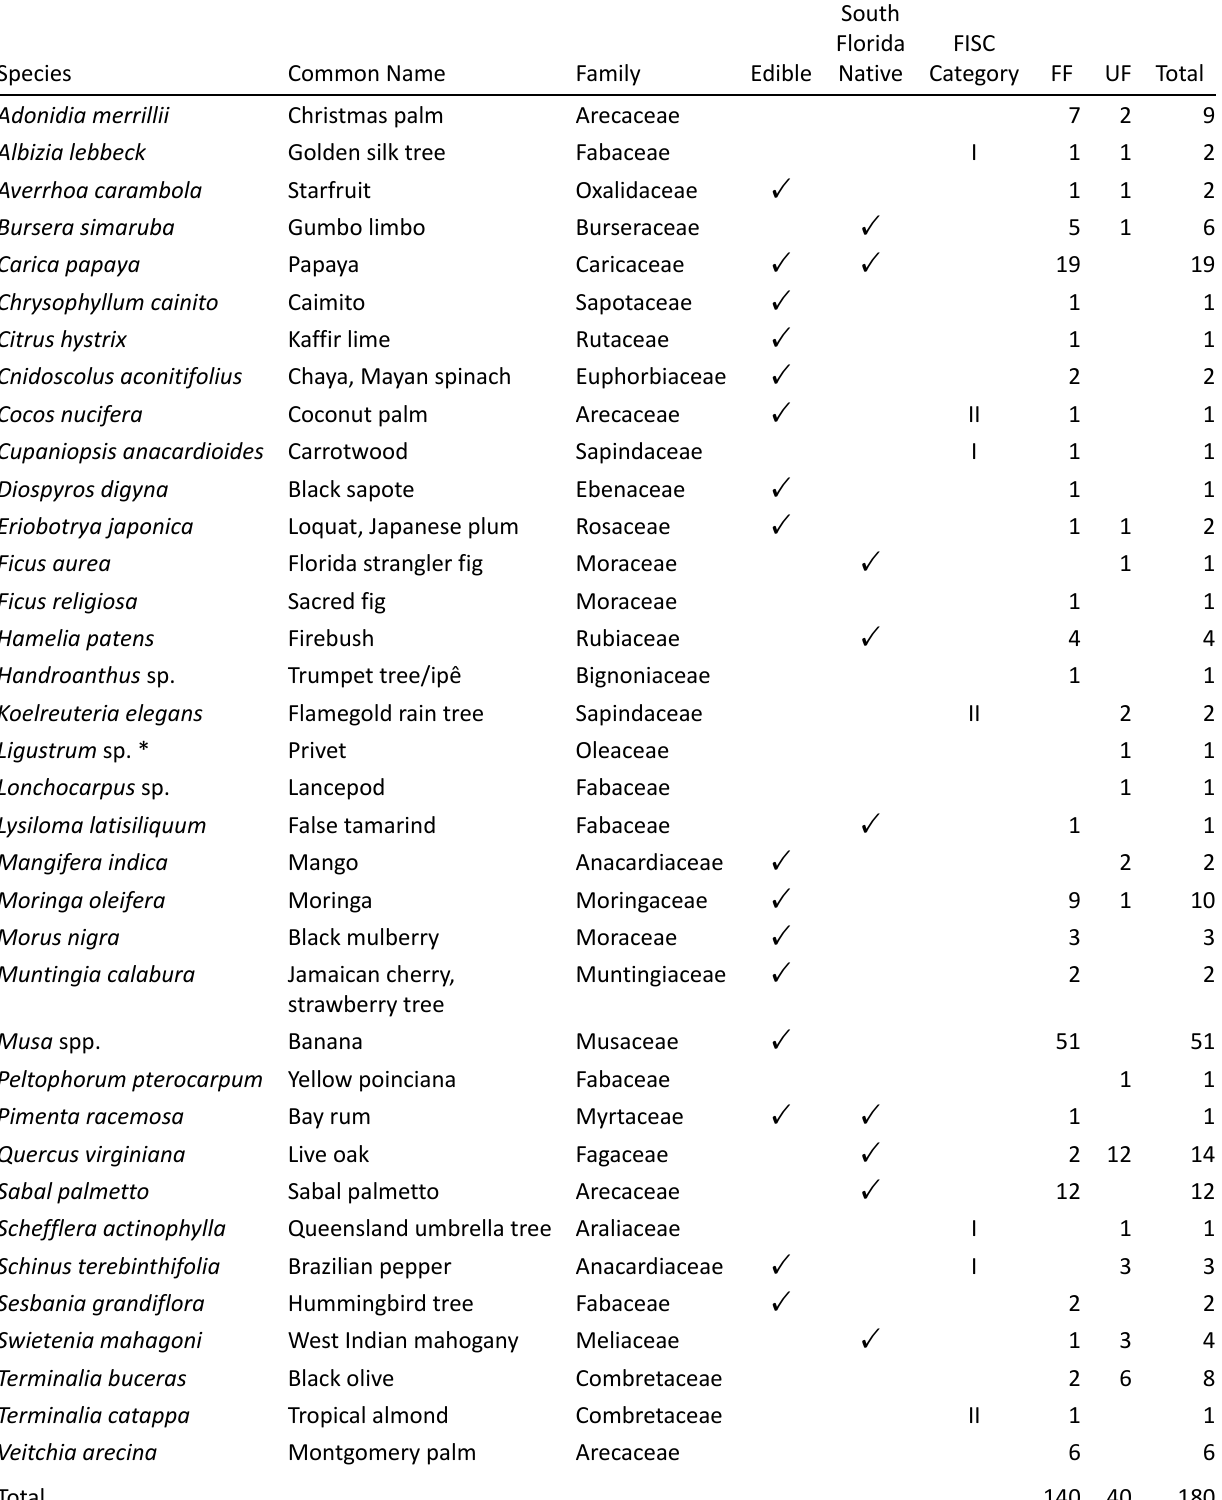
Table 1. Identified species, South Florida native status, FISC category, and number of stems in 10 FF and 10 UF plots in Miami‐Dade County,